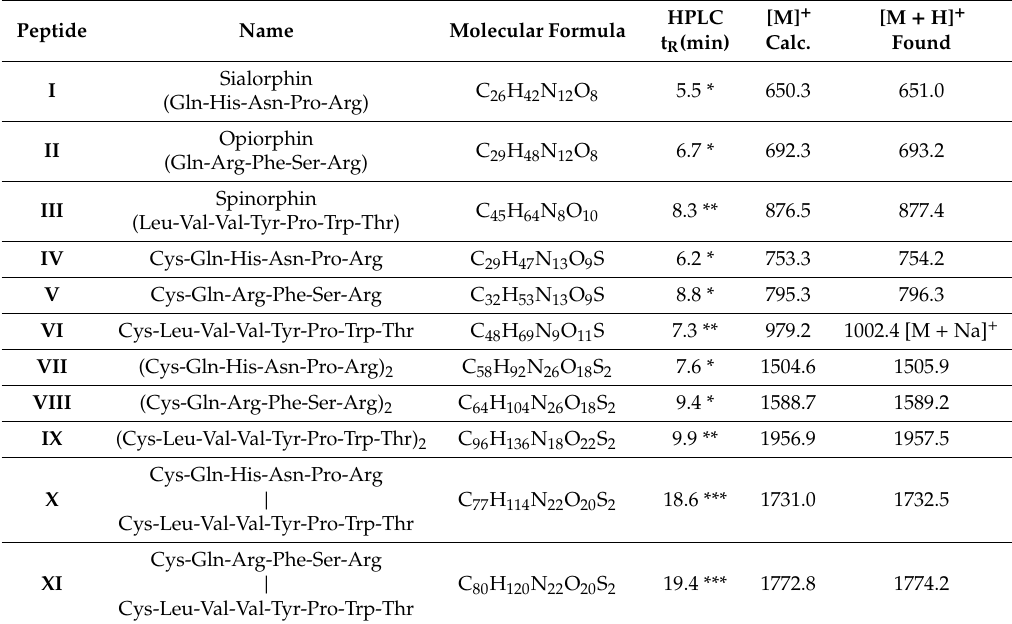
Table 1. Physicochemical properties of peptides I – XI